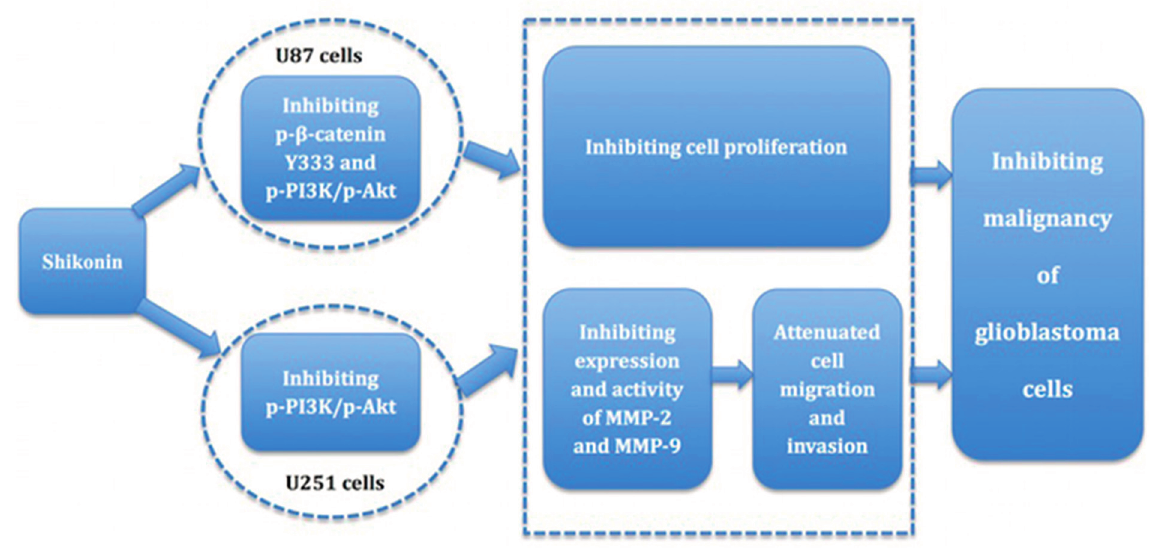
Figure 10. A scheme of the effects of shikonin on U87 and U251 human glioblastoma